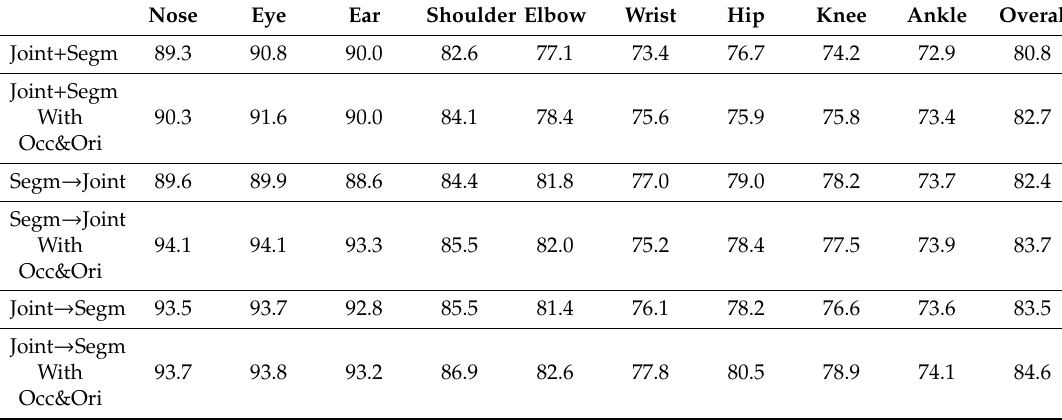
Table 2. Evaluation for joint position estimation of proposed models using the Percentage of Correct Keypoints (PCK;